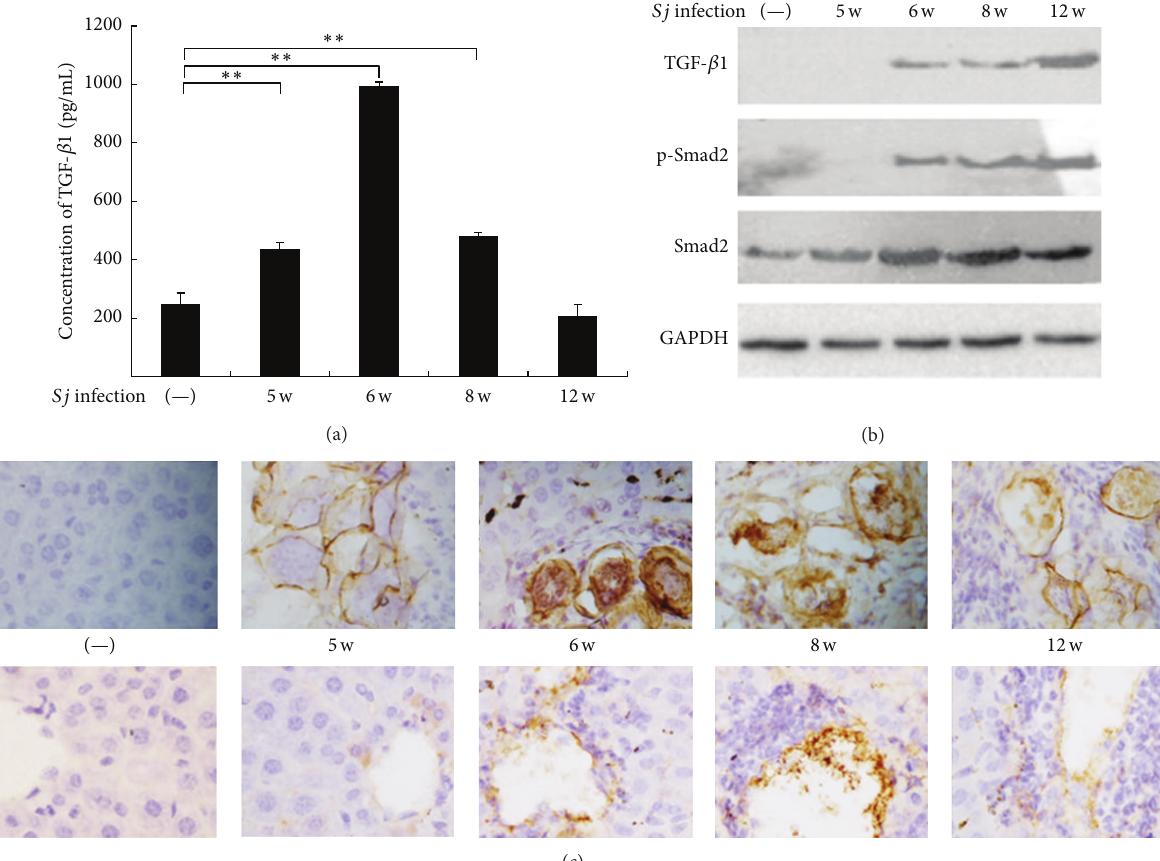
Figure 1: TGF- 𝛽 1 level increased gradually in mice liver during the courses of Sj infection. (a) TGF- 𝛽 1 level in serum was determined by ELISA in BALB/c mice with 20 ± 3 infective Sj cercariae for 5, 6, 8, and 12 weeks, and uninfected mice were used as control. Data are shown as means ± SD of 10 mice/group. Experiment was performed four times ( ∗ 𝑃 < 0.05 ; and ∗∗ 𝑃 < 0.01 compared with uninfected group). (b) Equal amounts of proteins of mouse liver tissue lysates at indicated time points were used in the Western blot assay to detect protein expression levels of TGF- 𝛽 1, p-Smad2, and Smad2. GAPDH was used as loading control. (c) Mouse livers at indicated time points were fixed in paraformaldehyde, embedded in paraffin, and then sliced and immunohistochemically stained for TGF- 𝛽 1. Representative staining for TGF- 𝛽 1 is shown at × 400 magnification. Top: TGF- 𝛽 1 expression in egg, Sj egg granuloma, and the surrounding tissue. Bottom: TGF- 𝛽 1 expression in hepatic cell and liver tissue around the liver